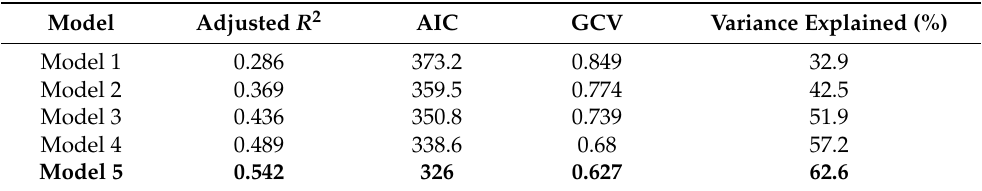
Table 3. Analysis of variance for generalized additive model (GAMs) fitted to ln(CPUE). Bold means